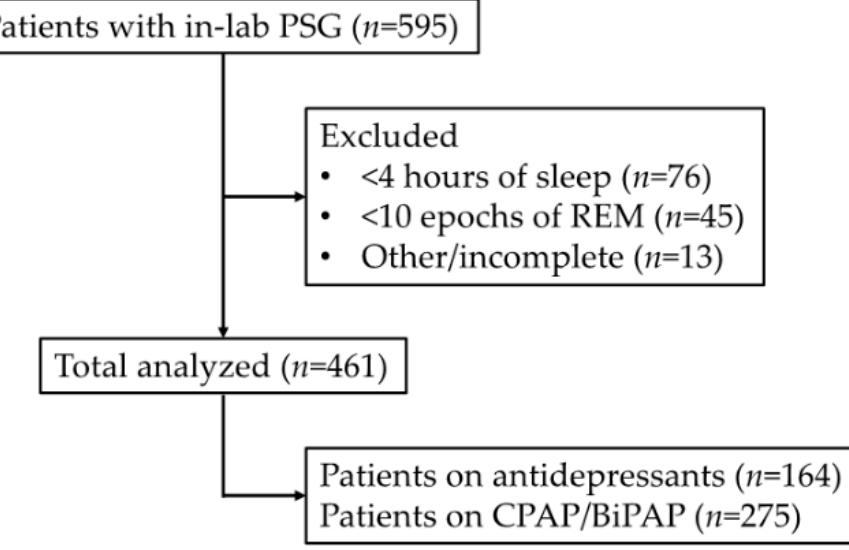
Figure 1. Schematic (CONSORT) overview of our patient population, exclusion criteria, and subse- quent sub-analysis groups. Of the total n = 595 participants evaluated with in-lab polysomnography (PSG), we excluded n = 134 records (due to having <4 h of total sleep time, n = 76; <10 epochs of REM sleep, n = 45, or were otherwise incomplete, n = 13). Of these n = 461 participants, n = 164 and n = 275 were noted to be currently using antidepressant medications or were on CPAP/BiPAP during their PSG, respectively. Since antidepressant use and presence of untreated obstructive sleep apnea have both been associated with increased EMG tone during REM sleep, we wanted to examine these groups as separate subsets, given that these conditions might affect the accuracy of our algorithm.